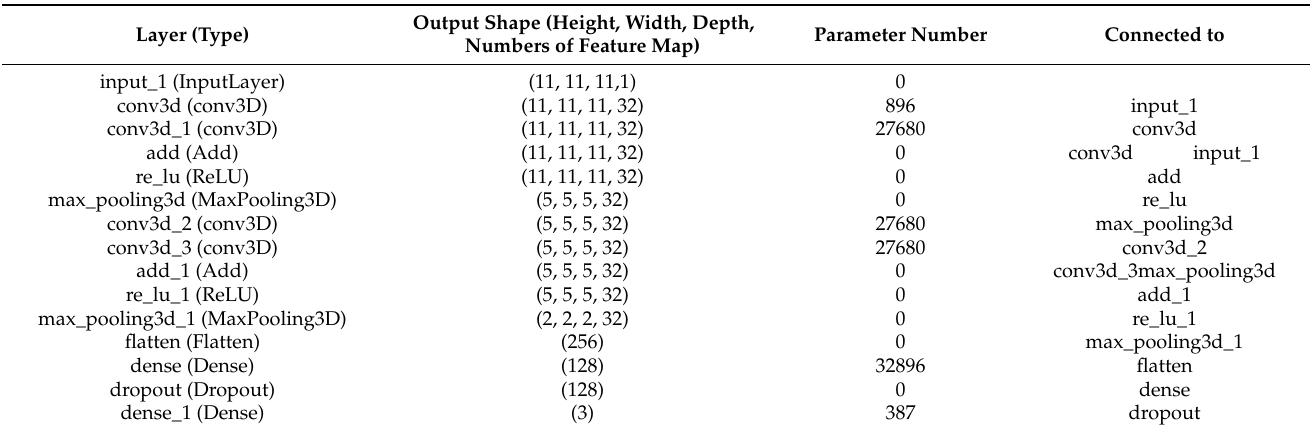
Table 2. Structure of the 3D-Res CNN